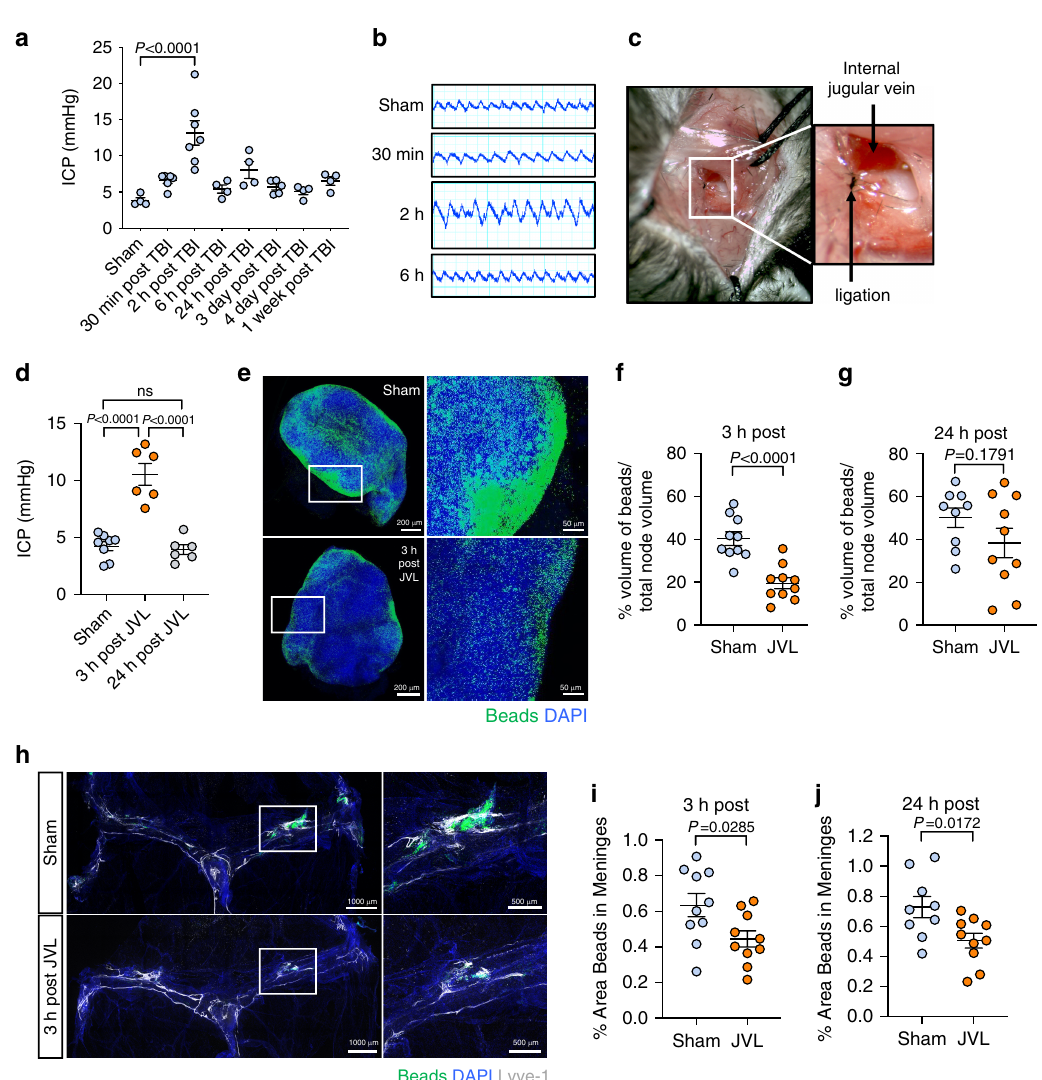
Fig. 3 Increases in intracranial pressure disrupt CNS lymphatic drainage. a Measurements of intracranial pressure (ICP) and b representative pressure readings were collected at various time points after TBI (Sham n = 4, 30 min n = 6, 2 h n = 7, 6 h n = 4, 24 h n = 4, 3 days n = 5, 4 days n = 4, 1 week n = 4; pooled data from three independent experiments). c Representative images of internal jugular vein ligation (JVL). d ICP readings from mice that underwent bilateral JVL or a sham procedure 3 or 24 h prior (Sham n = 8, 3 h n = 6, 24 h n = 6; pooled data from three independent experiments). e – j The internal jugular vein was ligated bilaterally and then 0.5 μ m fl uorescent beads were injected i.c.m. 3 h later. dCLN and meninges were then harvested from mice 2 h after bead injection. e Representative images of dCLN and graph showing drainage of beads ( f ) 3 h and ( g ) 24 h after jugular venous ligation. Each data point represents an average of the 2 dCLNs from an individual mouse (3 h: Sham n = 10, JVL n = 10, 24 h: Sham n = 9, JVL n = 10; pooled data from two independent experiments). Solid boxes of the node images on the left show zoomed insets of the images on the right. h Representative images of meningeal whole-mounts with 0.5 μ m beads (green) stained with DAPI (blue) and Lyve-1 660 (gray) and graph depicting percent area of bead coverage ( i ) 3 h and ( j ) 24 h post-JVL. Solid box shows a zoomed inset of the hotspot along the transverse sinus on the right (3 h: Sham n = 10, JVL n = 10, 24 h: Sham n = 9, JVL n = 10; pooled data from two independent experiments). All n values refer to the number of mice used and the error bars depict mean ± s.e.m. P values calculated by one-way ANOVA with Bonferroni ’ s multiple comparison test ( a ) and Tukey ’ s multiple comparison test ( d ) and two-tailed unpaired Student ’ s t -test ( f , g , i , j ). ICP intracranial pressure, JVL jugular venous ligation, h hour(s), min minute(s). Source data ( a , d , f – g , i – j ) are provided as a Source data fi